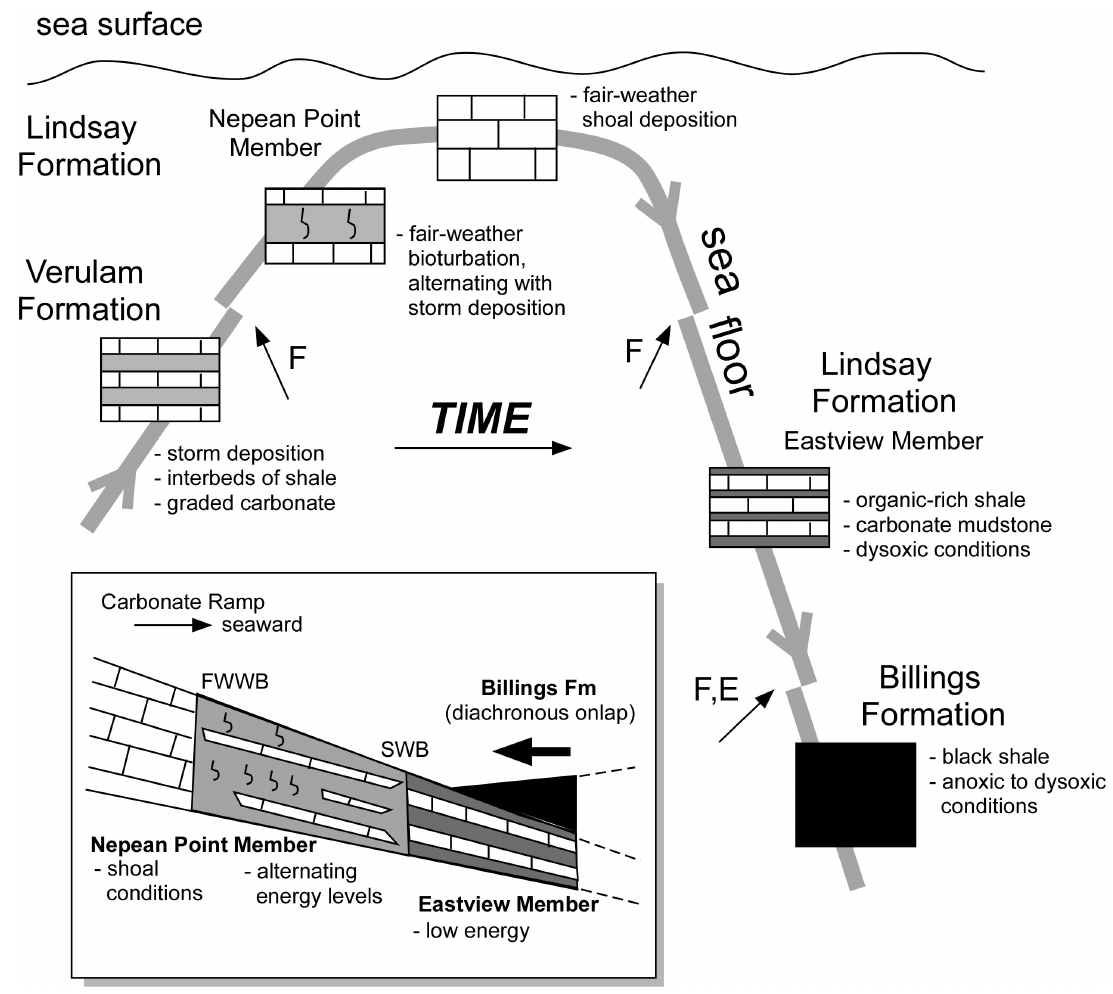
Figure 11. Interpreted change in relative water depth with time during the accumulation of the Verulam, Lindsay, and Billings formations in the Ottawa Embayment. Lateral facies distribution is configured to fit a carbonate ramp model [65]. Faulting (F) and erosional (E) events are indicated by arrows and the offsets along the seafloor path. Other abbreviations: FWWB, fair weather wave base; SWB, storm wave